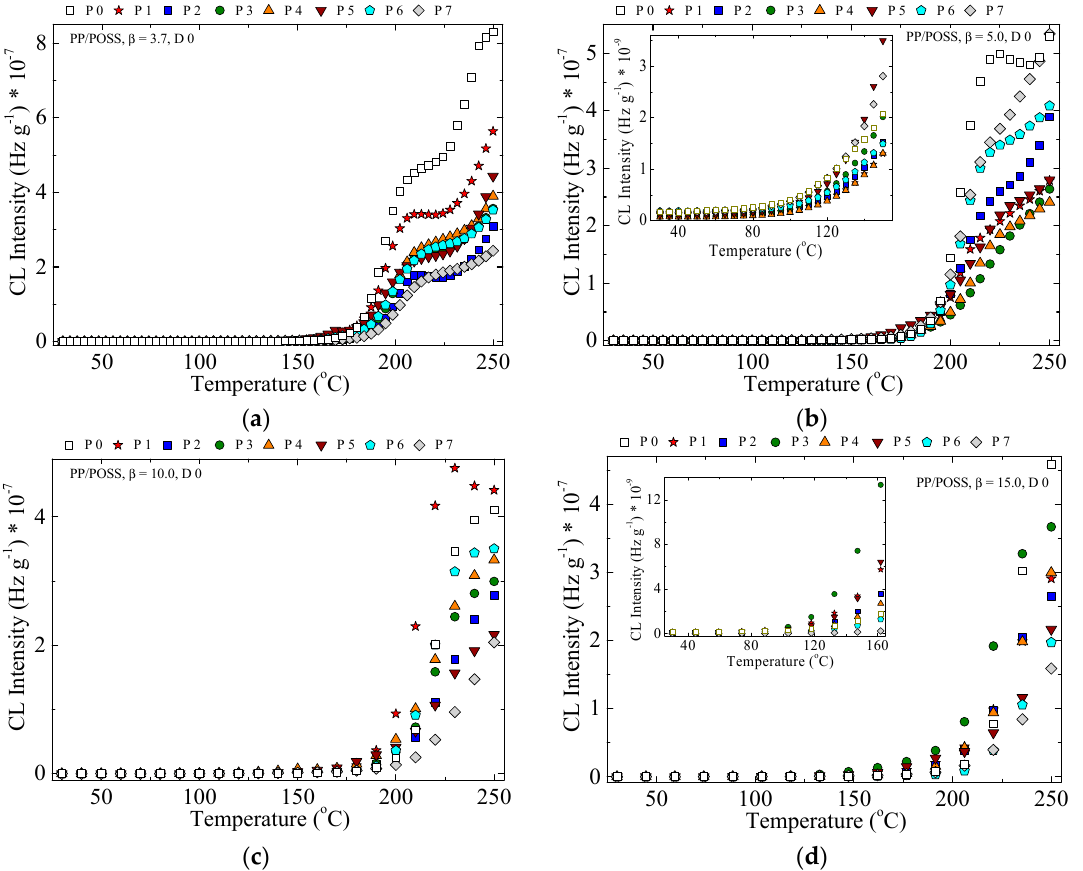
Figure 5. The progress of oxidation in the nonirradiated PP/modified-POSS samples at different heating rates: ( a ) 3.7 °C min − 1 ; ( b ) 5.0 °C min − 1 ; ( c ) 10.0 °C min − 1 ; ( d ) 15.0 °C min − 1 .